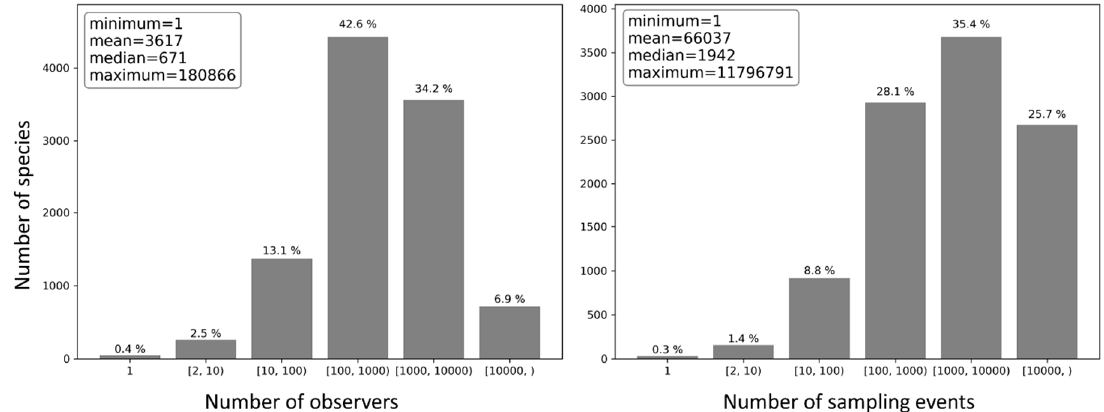
Figure 19. Distribution of the number of species by the number of observers who reported the same bird species ( left ) and by the number of sampling events in which the same species was reported ( right ).